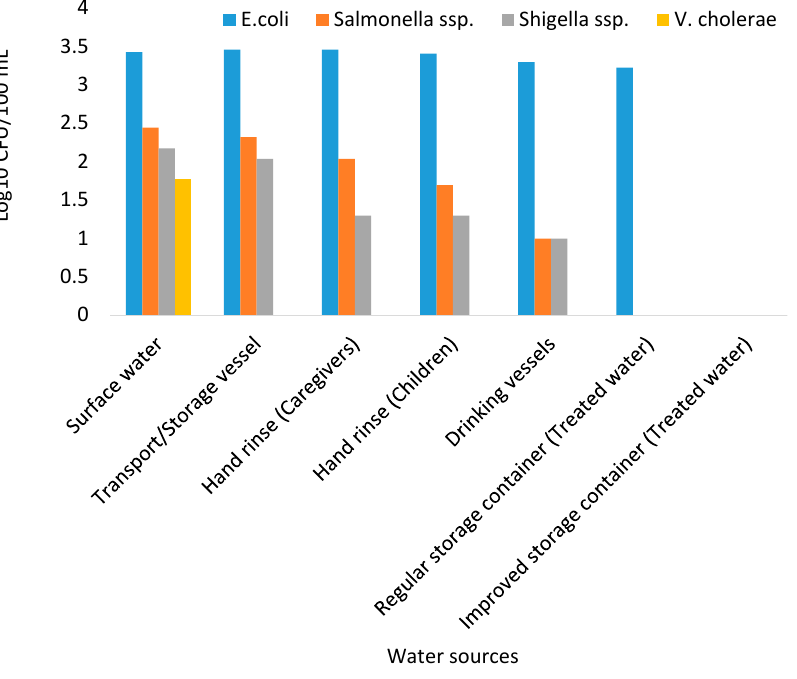
Figure 5. Mean concentration (Log10 CFU/100 mL) of presumptive enteropathogenic bacteria from different water sources in Makwane Village.